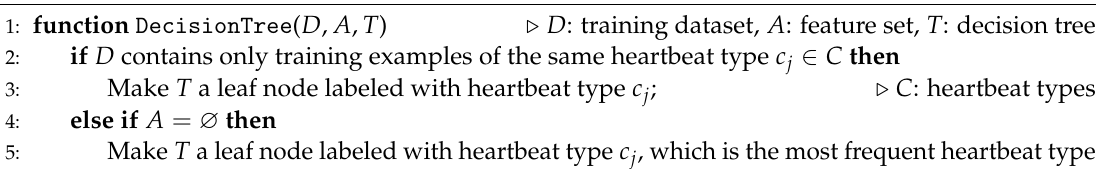
Algorithm 1 C4.5 algorithm for arrhythmia